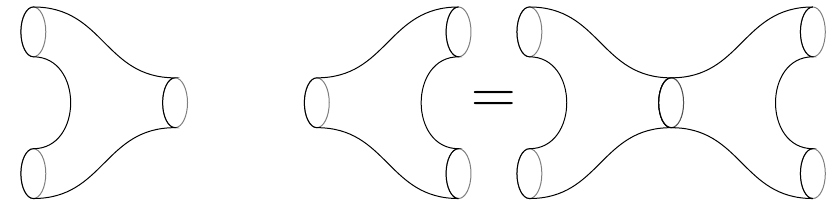
Figure 1 . A pair of pants decomposition of a sphere with four